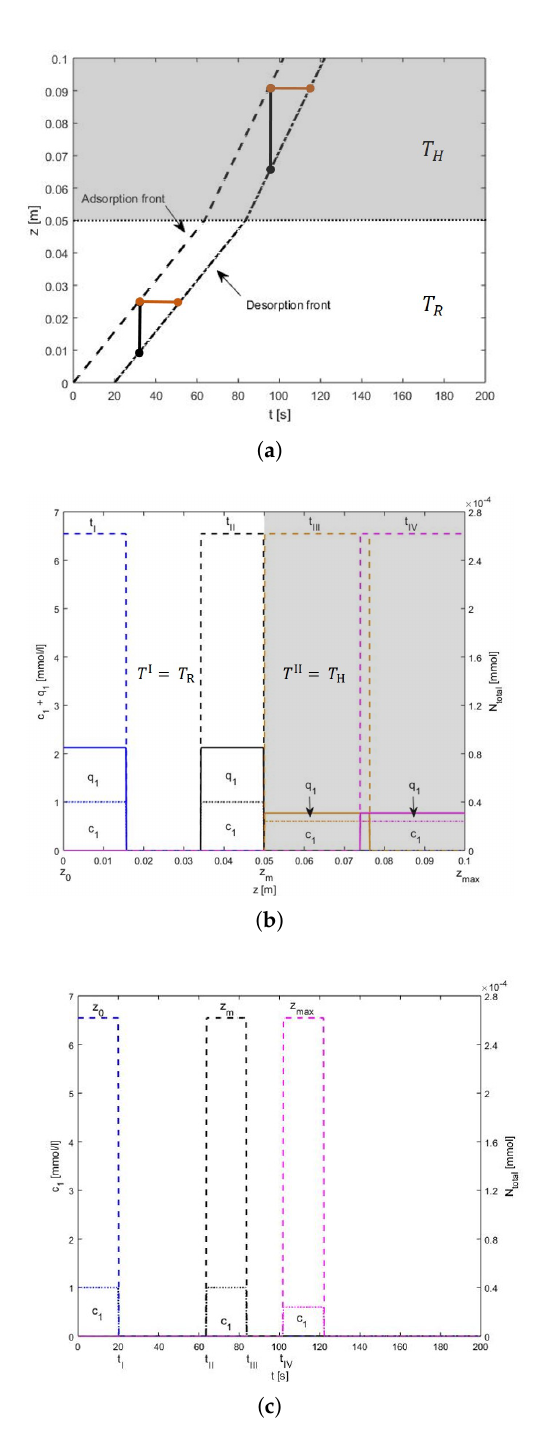
Figure 5. Illustration of the solution behavior for heating of Type I: Concentrations are plotted along the left axes and the total mass of the component, N total , showing the achievement of mass conservation, is plotted along the right axes of z -plot and t -plot. Segment II is kept at a high temperature. ( a ) The pulse is accelerated but in segment II, space-bandwidths become broader as compared to segment I. The time-bandwidth stays the same as in the previous case. ( b ) The blue color is showing the position of the pulse at t I = t inj = 20 s , in black color, when its adsorption front reaches z m , in orange color, when its desorption front reaches z m and it is plotted in pink color when its adsorption front reaches z max . ( c ) The blue color profile is showing the arrival times of both the fronts at z 0 , black color, when they reach z m and the pink color profile is showing when they reach z max